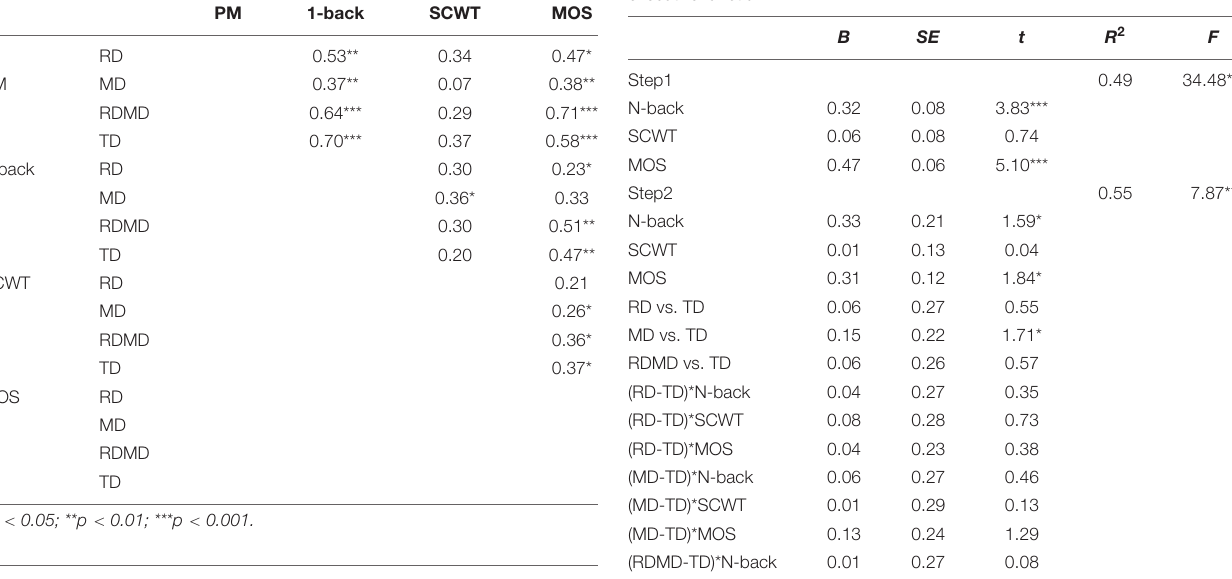
TABLE 4 | Regressions models predicting students’ performance in the prospective memory (PM) task. Group Variable